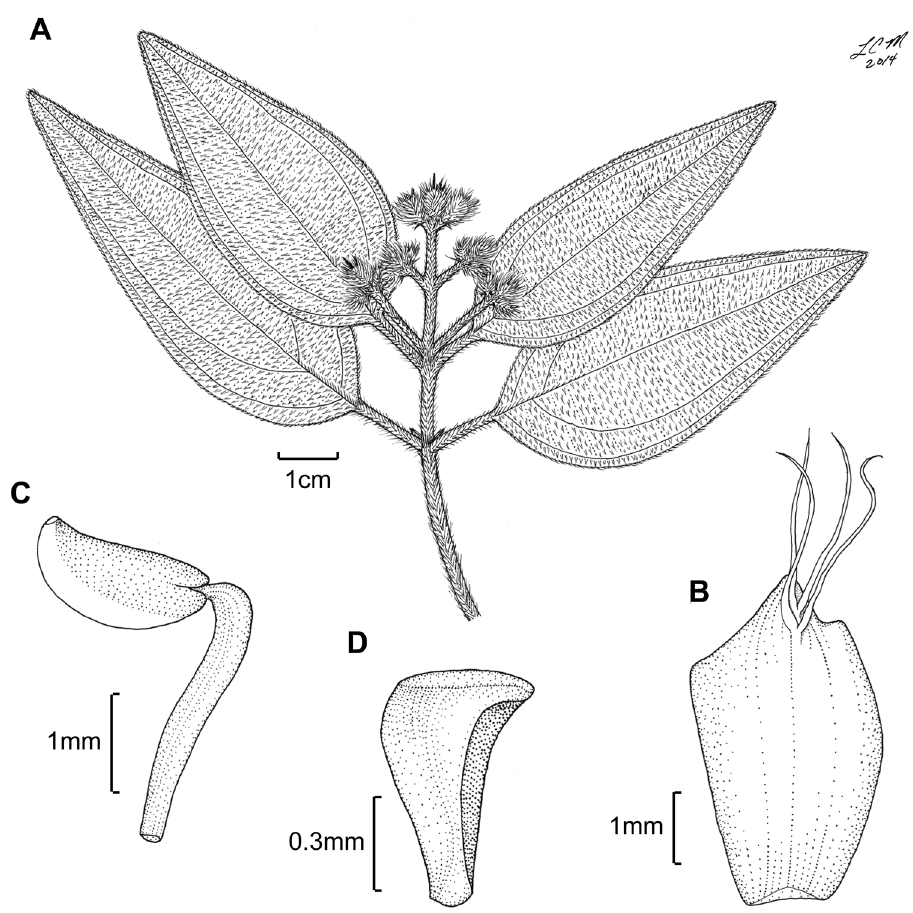
Figure 14. Illustration of Miconia argentimuricata . A Habit ( Ekman 3702 ) B petal abaxial surface show- ing multiple, long, slightly bulla-based hairs ( Ekman 15940 ) C stamen ( López-Figueiras 2180 ), and D seed ( Ekman 15940